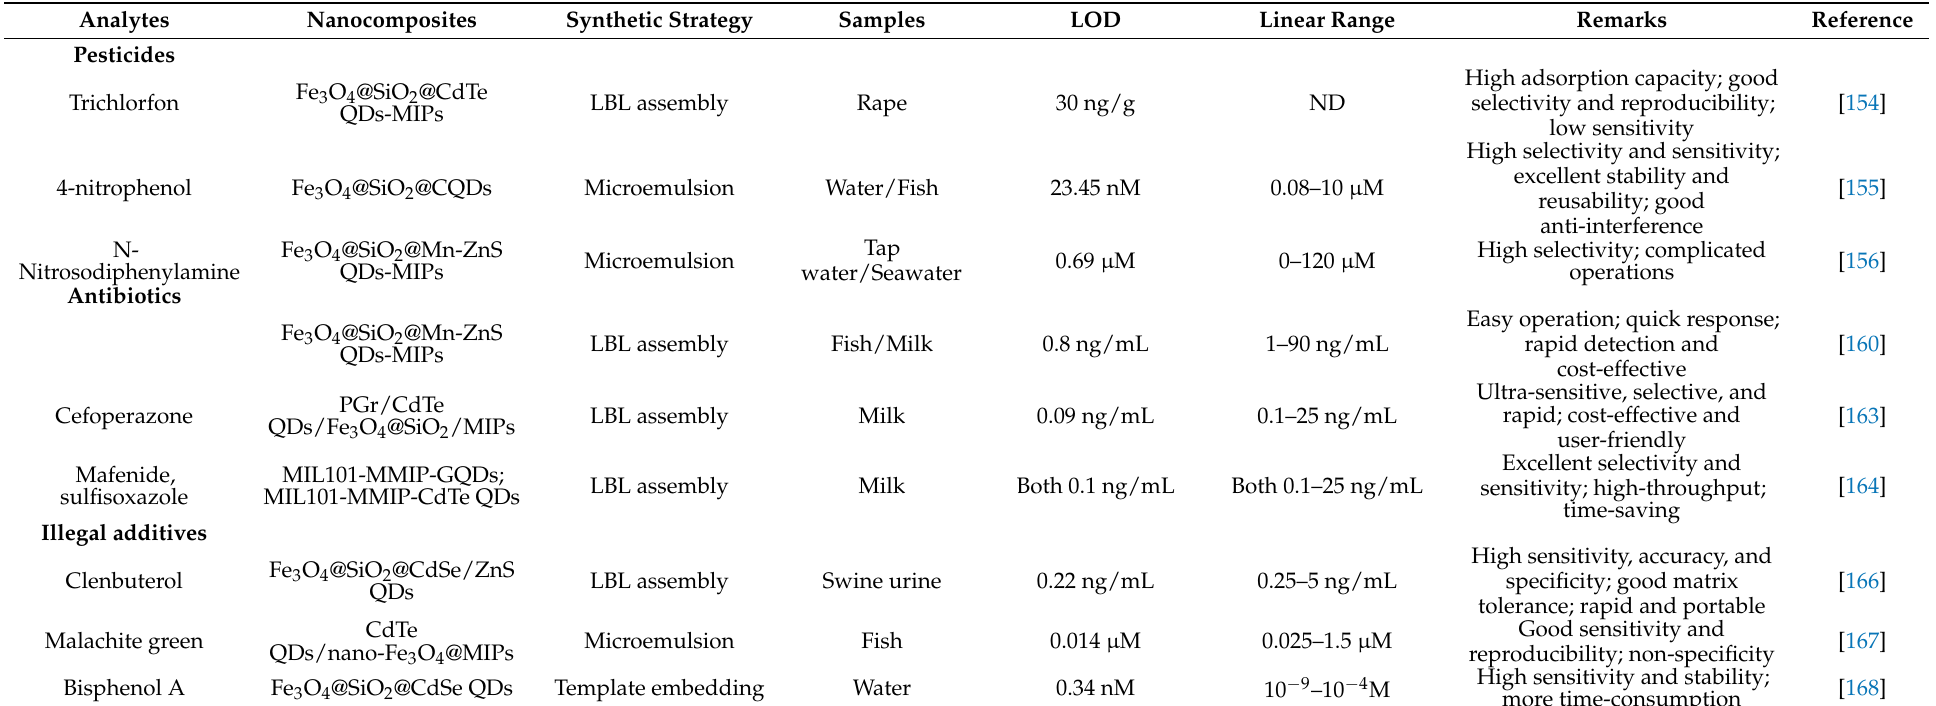
Table 4. Detection performances of MNPs@QDs-based sensors for pesticides, antibiotics, and illegal